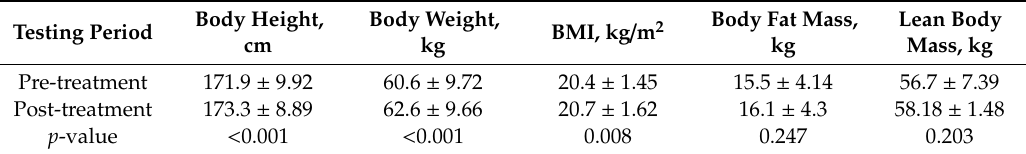
Table 4. Body height (cm), body weight (kg), BMI, body fat mass percentage, and lean body mass percentage in group 1 pre- and post-treatment (mean value ±